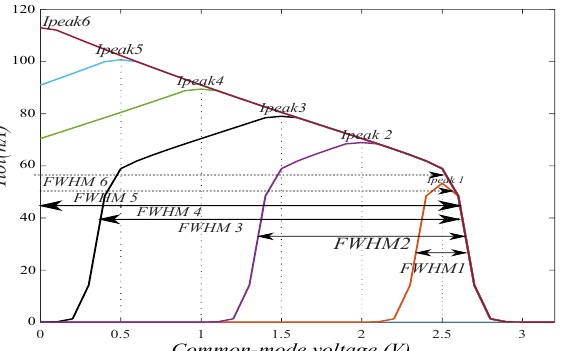
Figure 13. Simulation of total current for similarities between inputs at common-mode voltages 0 V, 0.5 V, 1 V, 1.5 V, 2 V, 2.5 V, and 3 V. The bias voltage is 2.6 V in this simulation. Arrows show the FWHM for each common-mode value.